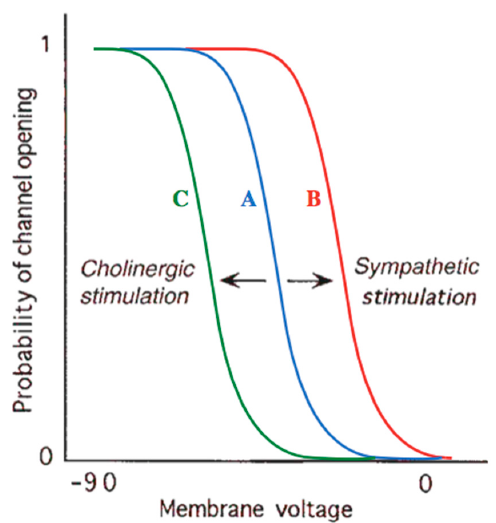
Figure 2. Effects of cholinergic and sympathetic stimulation on pacemaker channel. At any given voltage, there exists a chance between 0 and 1 that a certain channel will be disclosed. Compared with normal baseline behavior (curve A), sympathetic stimulation (curve B) or treatment with anticholinergic drugs shifts this possibility to a higher value or any given level of membrane voltage, thus elevating the number of disclose channels and the rate at which the cell will free. Curve C shows that parasympathetic cholinergic stimulation (or treatment with a β -blocker, which antagonizes sympathetic stimulation) has the contradictory effect, lowering the probability of a channel being disclose and therefore blocking depolarization [45]. Table 1. Β eta-blocker agents used worldwide.